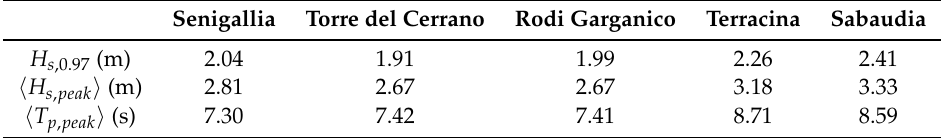
Table 3. Wave climate statistics for each study site: wave height threshold for storm classification H s ,0.97 , mean significant wave height at classified storm peaks (cid:104) H s , peak (cid:105) , and mean peak period at classified storm peaks (cid:104) T p , peak (cid:105) . Senigallia Torre del Cerrano Rodi Garganico Terracina Sabaudia H s ,0.97 (m)